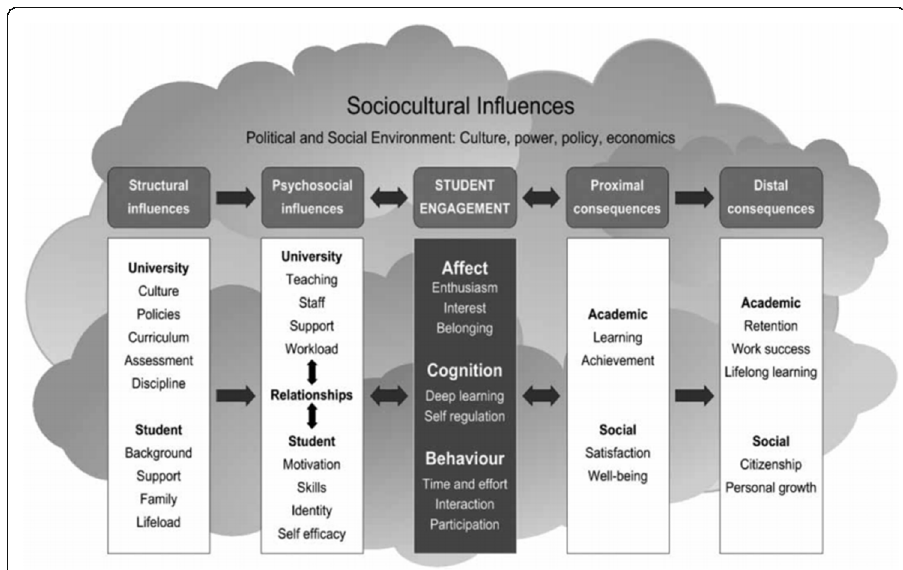
Fig. 1 Conceptual framework of engagement, antecedents and consequences (Kahu, 2013, p. 766). Reproduced with